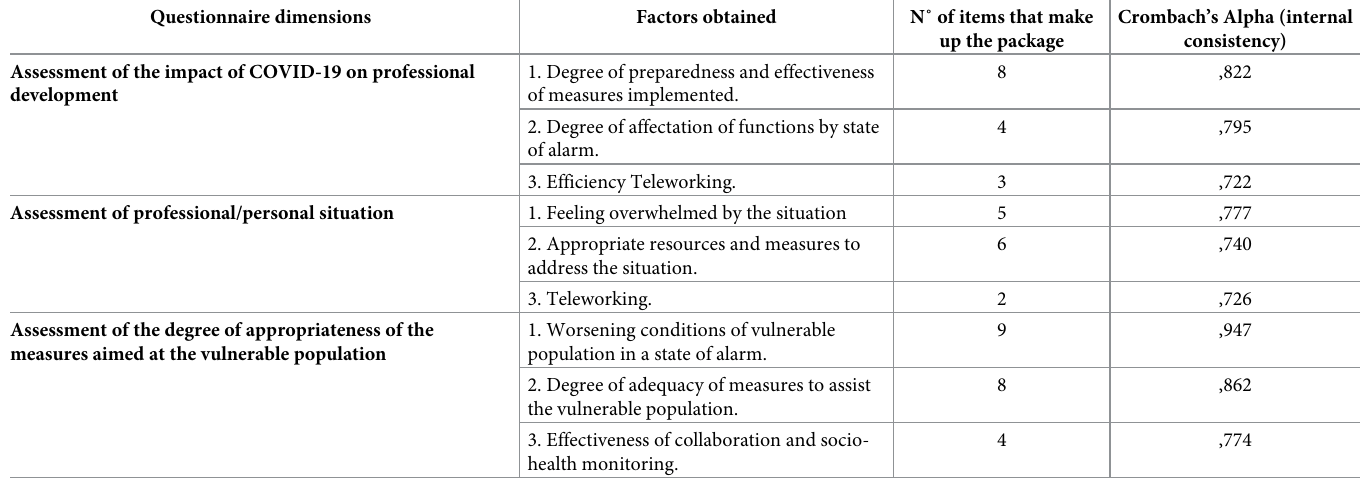
Table 2. Factorial analysis.